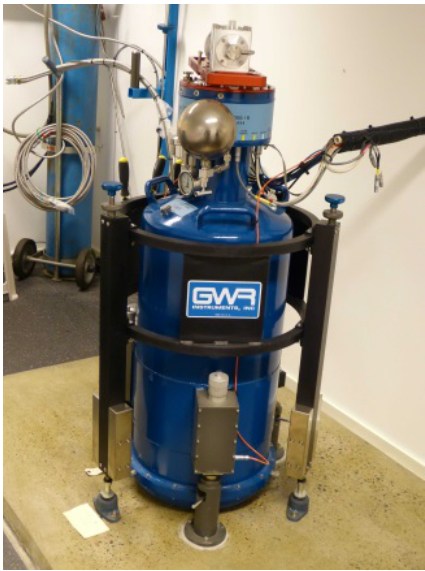
Figure 5: Superconducting gravimeter GWR#54 at Onsala Space Observatory.